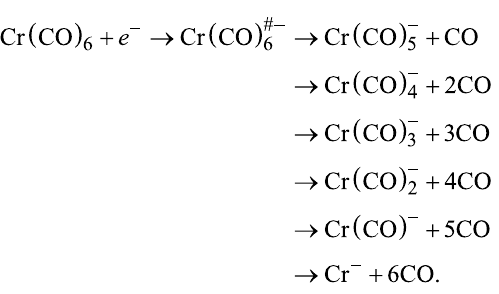
These six reactions describe the series of loss of the organic CO ligand. In contrast to W(CO) 6 [13], the series of CO loss is complete in the present case, with the formation of the bare metal anion. This is in agreement with Pignataro et al. [20], where the six anionic species where reported. The correspond- ing anion yields indicate that the number of leaving CO ligands increases with the electron energy. In Table 1 appearance ener- gies and peak positions are listed and compared with the results from Pignataro and co-workers. The appearance energies are in good agreement, and the maximum deviation from the previous values is 0.45 eV for Cr − formation [20].